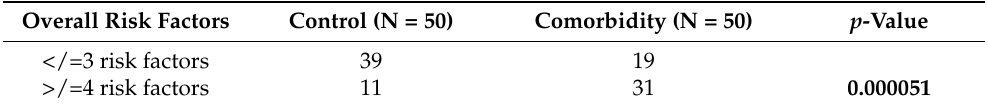
Table 6. Association of number of risk factors as compared to principal diagnosis.